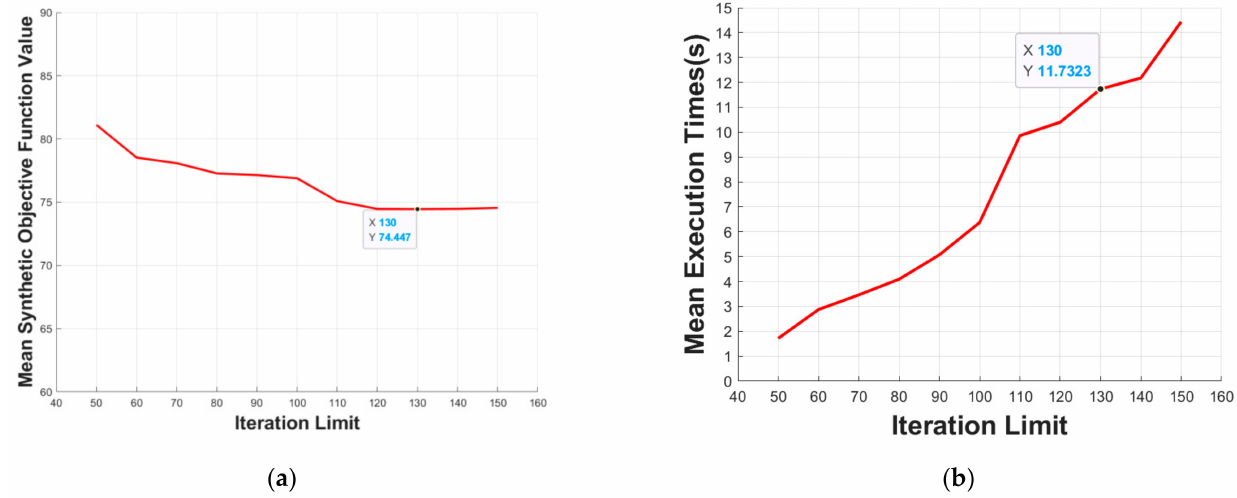
Figure 14. Effect of the iteration limit on: ( a ) mean synthetic objective function value; ( b ) mean execution time.